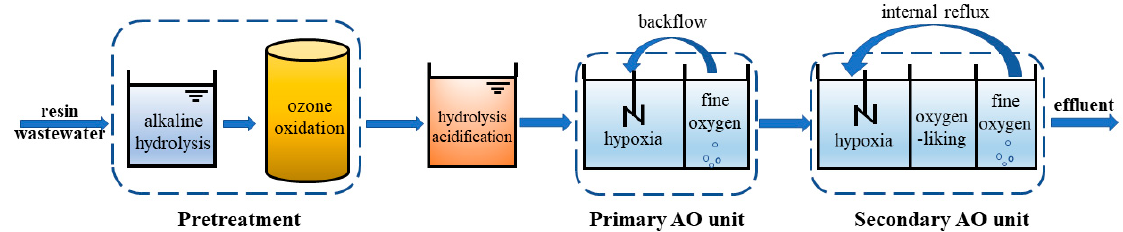
Figure 1. Pretreatment hydrolysis acidification/AO combined process flow chart.